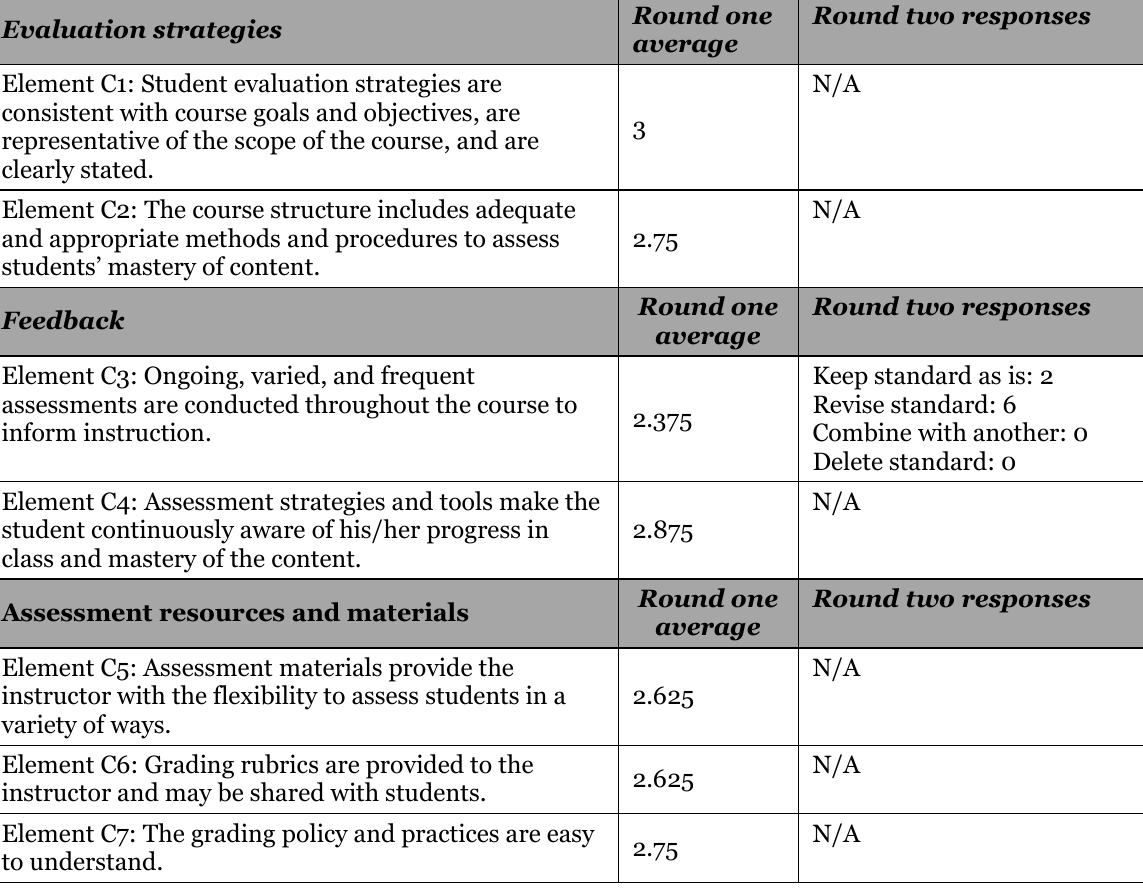
Round one Round two average